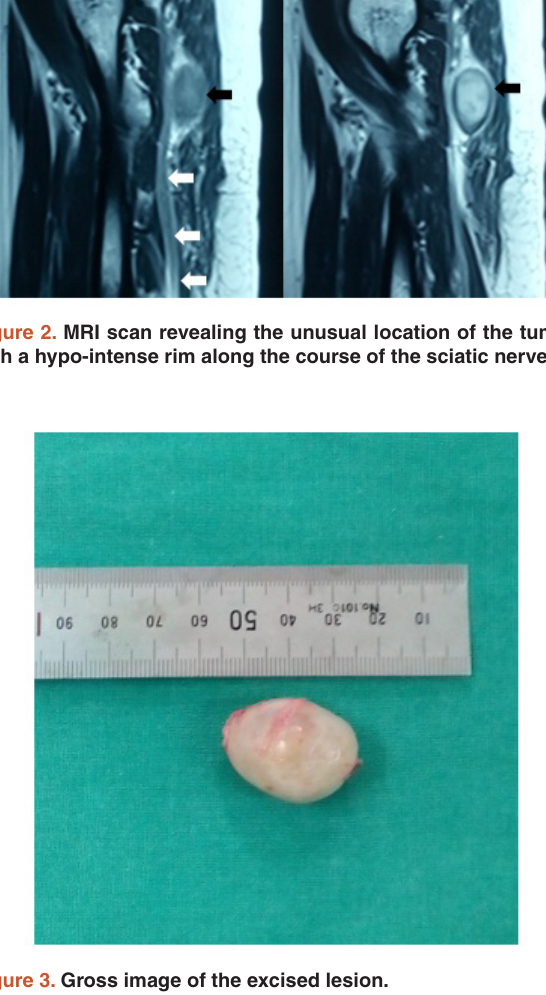
Figure 3. Gross image of the excised